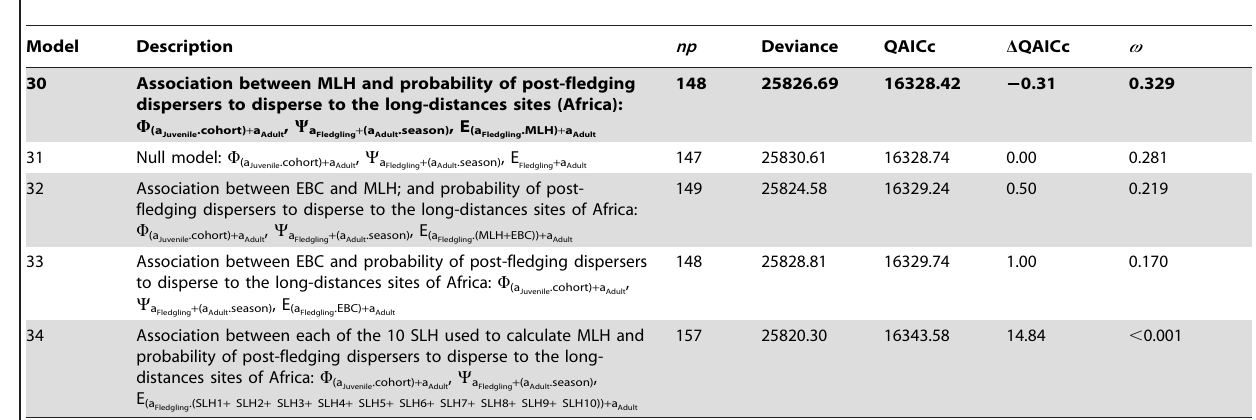
larger sample size. Table S5: Models of early body condition of greater flamingos. Table S6: Model averaged parameter estimates of models predicting early body condition of greater flamingos. Figure S4: Adjusted mean early body condition ( 6 SEM) of greater flamingo chicks according to cohort and sex (using model 1 in Table S5).